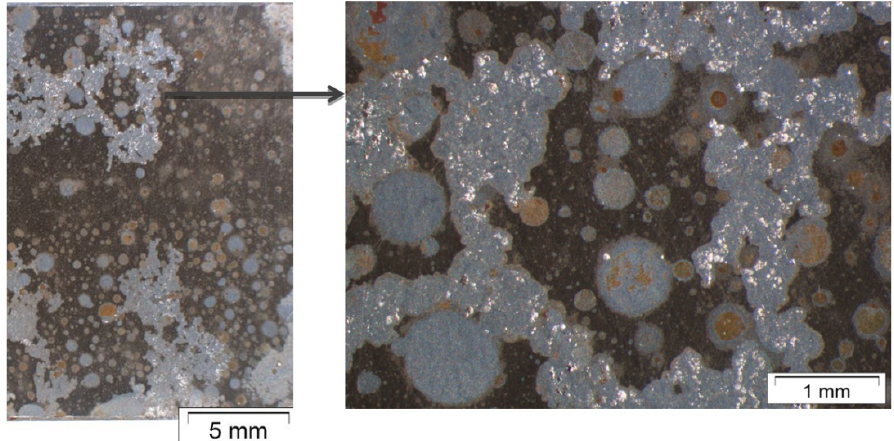
Figure 6. Corroded surfaces of X35CrMo17 after 8000 h of exposure to water-saturated supercritical CO 2 at 60 °C and 100 bar.